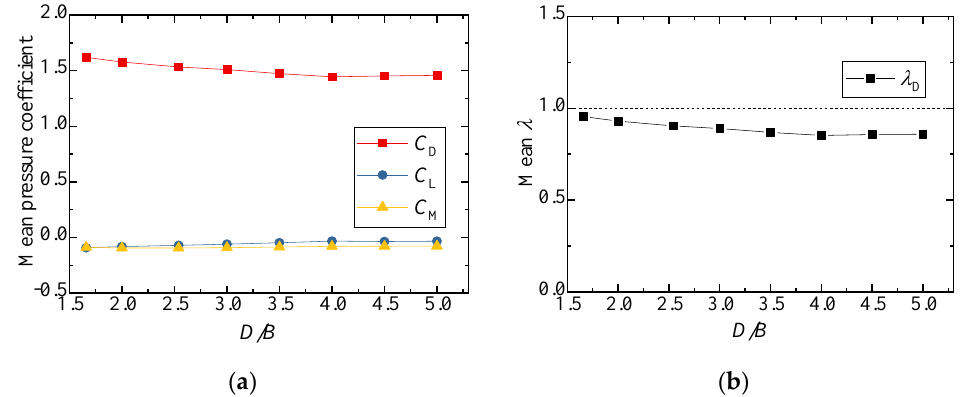
Figure 16. Wind pressure coefficient of the vehicle for Case 3: ( a ) Mean value; ( b ) RMS value.